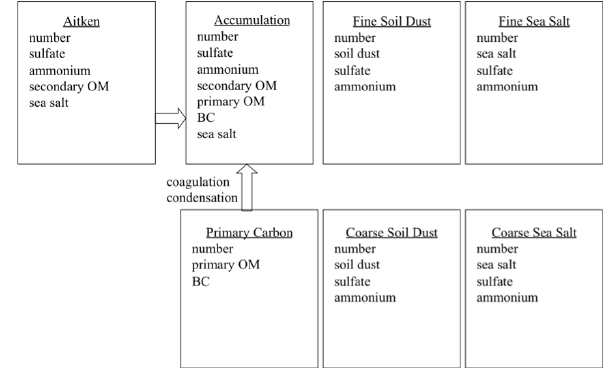
Fig. 1. Predicted species for interstitial and cloud-borne component Figure 1. Predicted species for interstitial and cloud-borne component of each aerosol of each aerosol mode in MAM7. mode in MAM7.